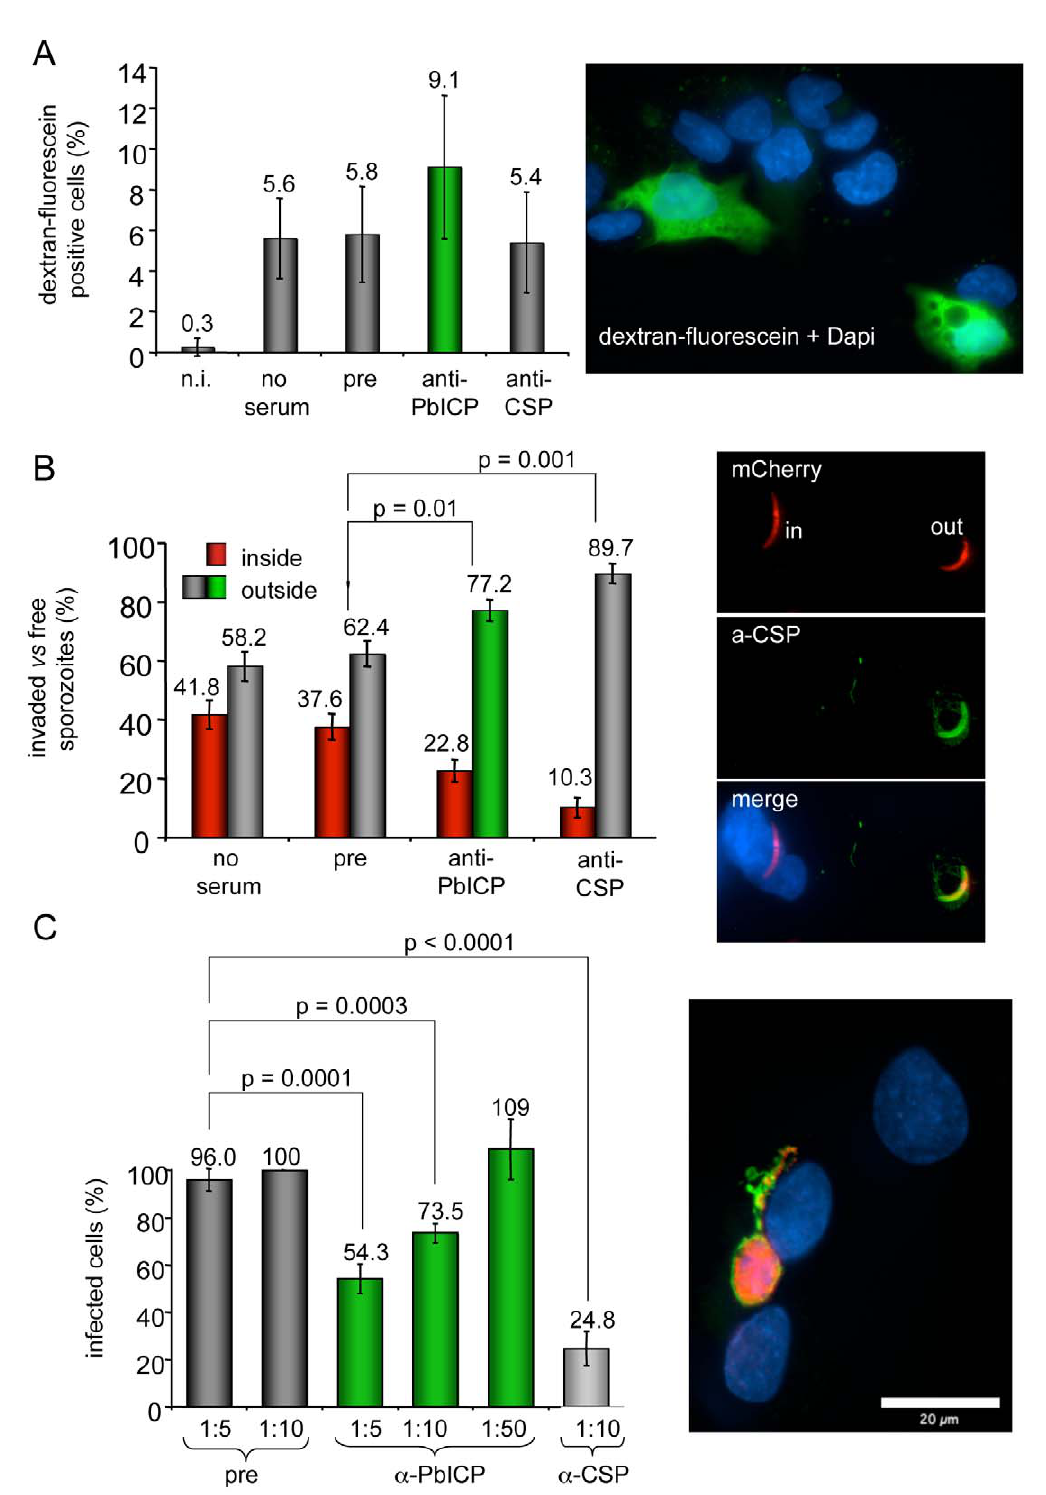
Figure 7. Antibody-mediated neutralization of PbICP reduces infectivity of sporozoites invitro but does not inhibit cell traversal of sporozoites. ( A ) Transmigration assay: P. berghei sporozoites were pre-incubated with medium (no serum) preimmune serum (1:5), anti-PbICP-C antiserum (1:5) or anti-CSP-antiserum (1:5) and subsequently added to HepG2 cells in the presence of 1 mM dextran-fluorescein for 1 h to stain wounded cells. Non-infected HepG2 cells (n.i.) cultivated in the presence of 1 mM dextran-fluorescein for 1 h served as a negative control for cell wounding. After this incubation period cells were washed, fixed and the DNA was stained with DAPI to allow visualization of both intact and wounded cells. The total cell number compared to dextran-fluorescein positive cells was determined using an immunofluorescence microscope and the percentage of dextran-fluorescein positive cells was calculated. Presented are the means and standard deviations of three independent